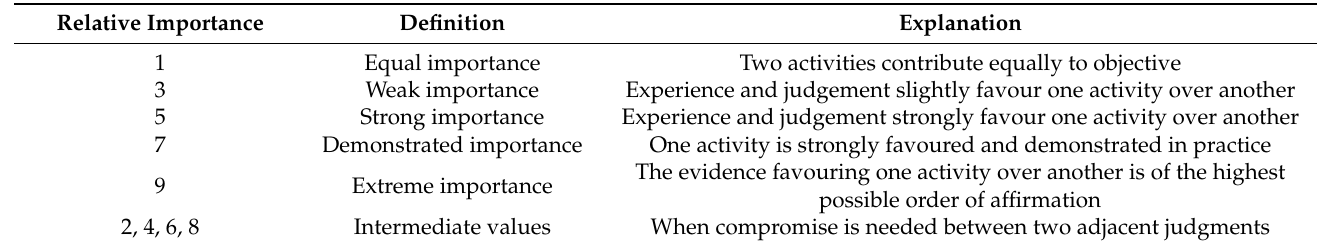
Table 2. Determination of relative importance based on own study [90].